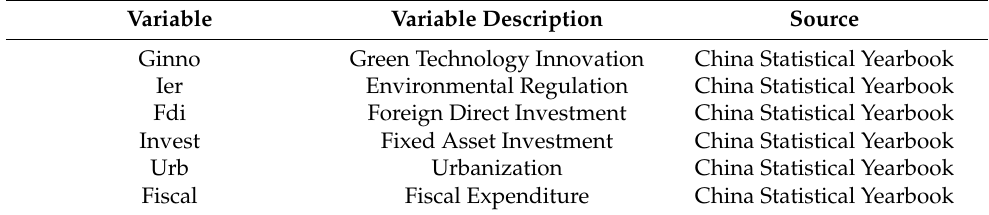
Table 1. Variable